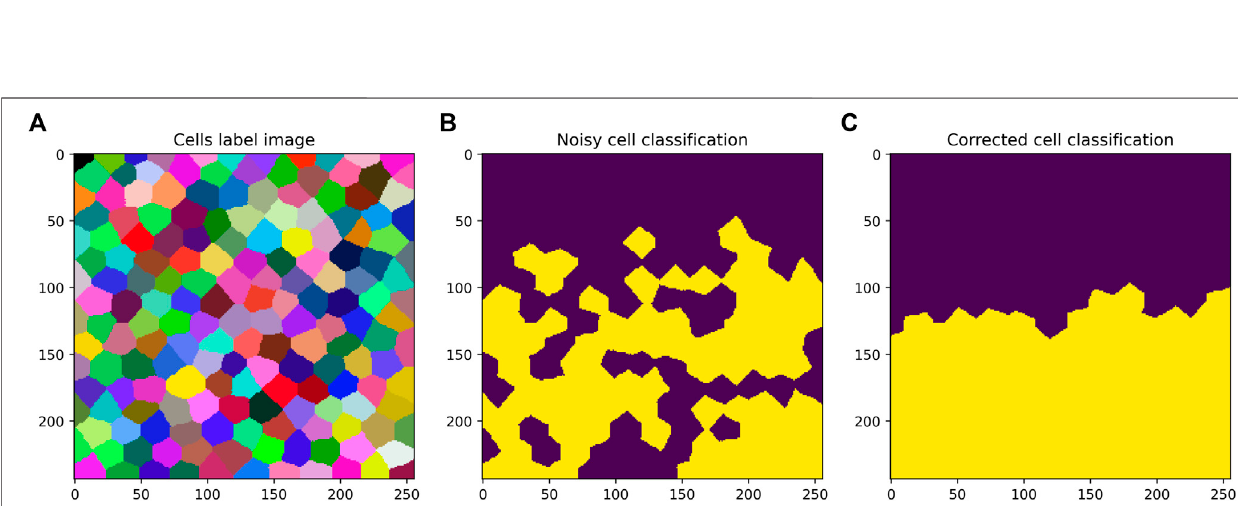
Frontiers in Computer Science |